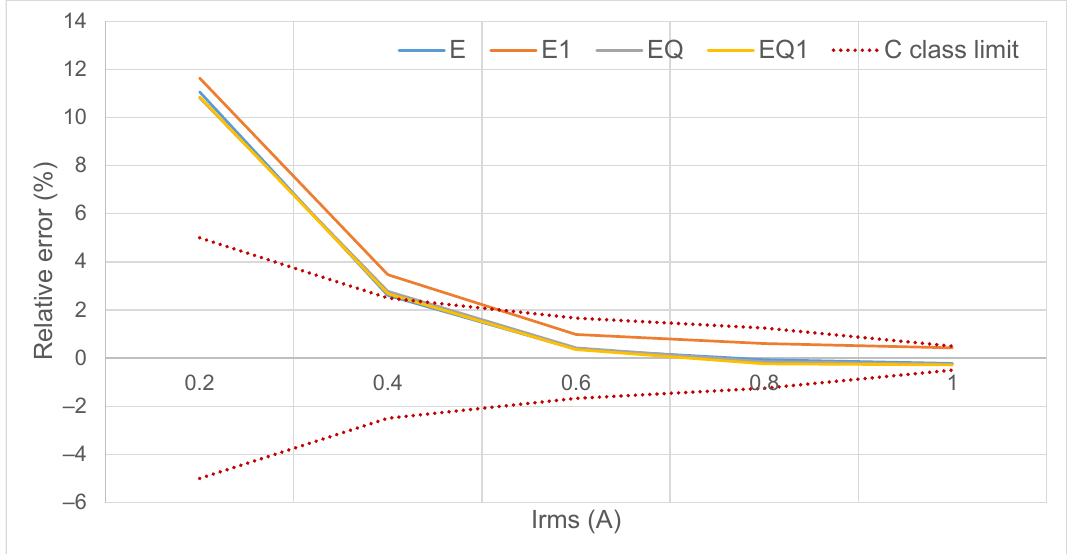
Figure 7. Sinusoidal tests results for 0.2–1% ADC full scale.